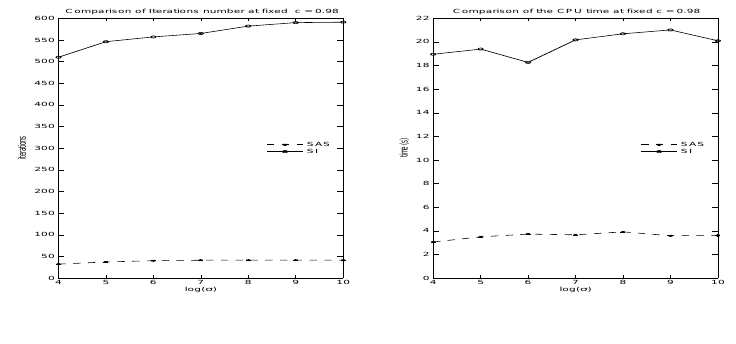
Figure 5. Comparison of the SI and SAS methods in 2D case at fixed c = 0 . 98 , for large σ ( ǫ = 1 E − 5 ): (left) number of iterations; (right) CPU time.